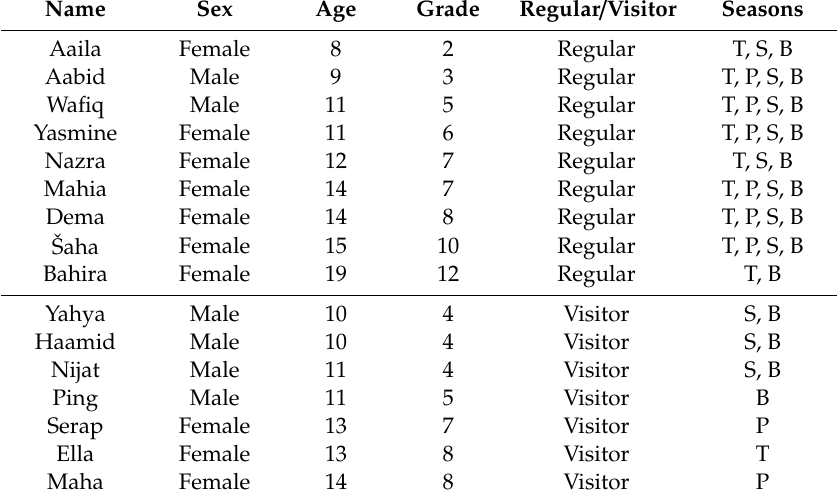
Table 2. Overview of youth participants (name, sex, age, grade, regular / visitor, seasons).